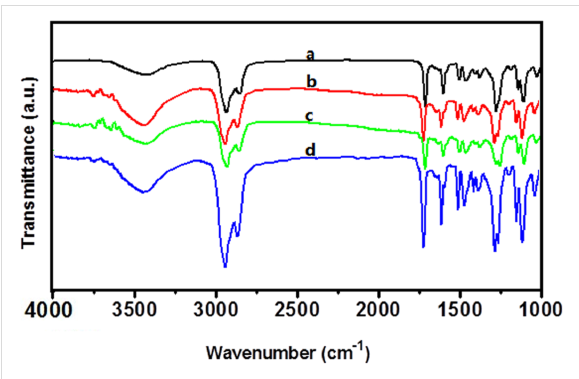
Figure 6: XRD patterns of xerogels. (a) ethanol, (b) isopropanol and (c)